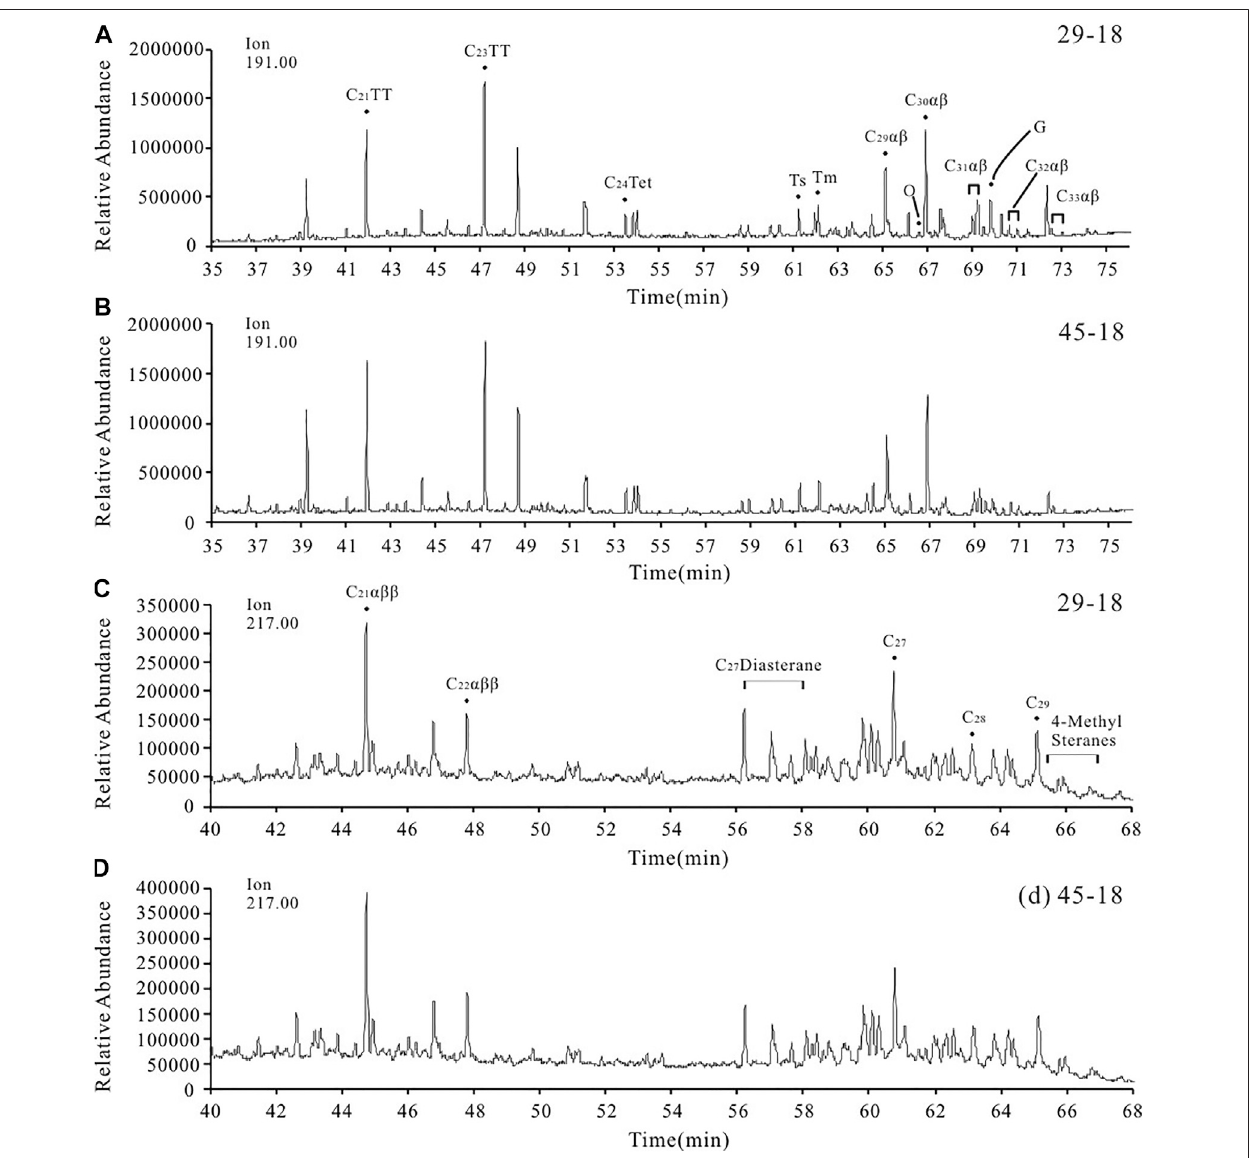
FIGURE 6 | Representative mass chromatogram (m/z 191) for terpane and (m/z 217) for sterane series of organic matter extracted from core sediments. (a): TT (cid:2) tricyclic terpanes; Tet (cid:2) tetracyclic terpane; O (cid:2) oleanane; G (cid:2) gammacerane; (c):C 21 αββ - C 22 αββ (cid:2) C 21 αββ - C 22 αββ pregnane; C 27 -C 29 (cid:2) ααα R C 27 -C 29 sterane.